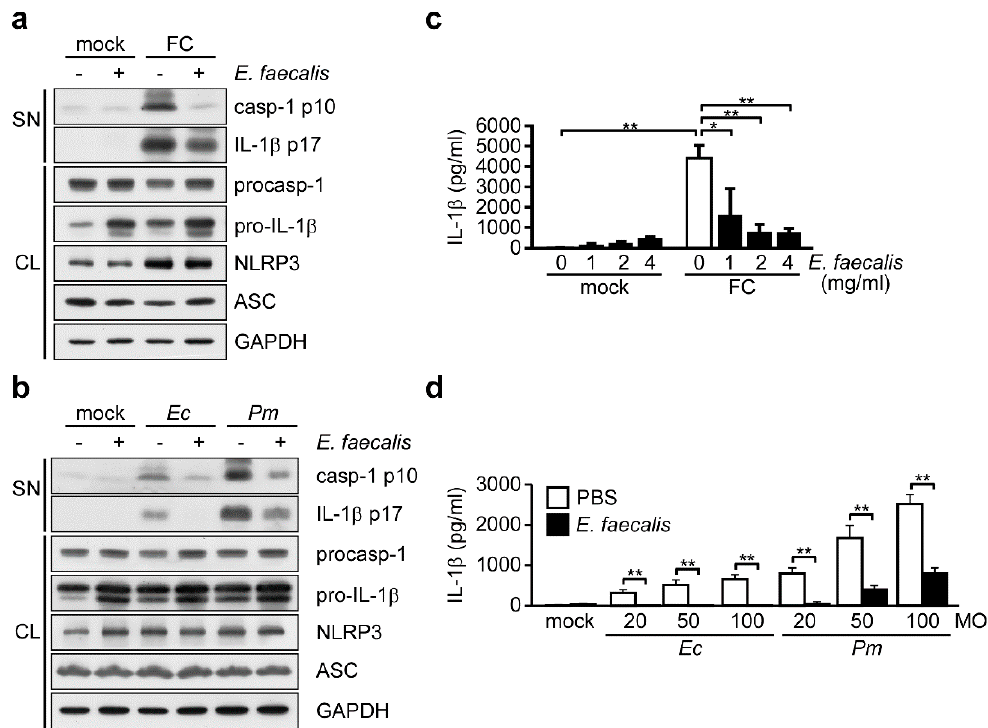
Figure 2. E. faecalis attenuates bacteria-induced IL-1 β secondsretion. ( a , b ) Immunoblot analysis of NLRP3 inflammasome molecules in cell SN and CL from THP-1-derived macrophages pretreated with E. faecalis (2 mg/mL) for 24 h and then incubated for 3 h with ( a ) FC, ( b ) Ec (MOI 100) or Pm (MOI 100). The western blot is a representative of three independent experiments. ( c , d ) ELISA of IL-1 β in the SN of THP-1-derived macrophages pretreated with E. faecalis at the dose as indicated ( c ) or 2 mg/mL ( d ) for 24 h and then infected for 3 h with FC ( c ), or Ec or Pm at 20, 50 or 100 MOI ( d ). ELISA data were analyzed with the ANOVA test followed by post hoc test. *, p < 0.05; and **, p < 0.01. All results are presented as the mean ± SD of three independent experiments. Abbreviations: casp-1 p10, active caspase-1 subunits; IL-1 β p17, secondsreted mature IL-1 β ; procasp-1, p45 precursor of caspase-1; and pro-IL-1 β , p31 precursor of IL-1 β